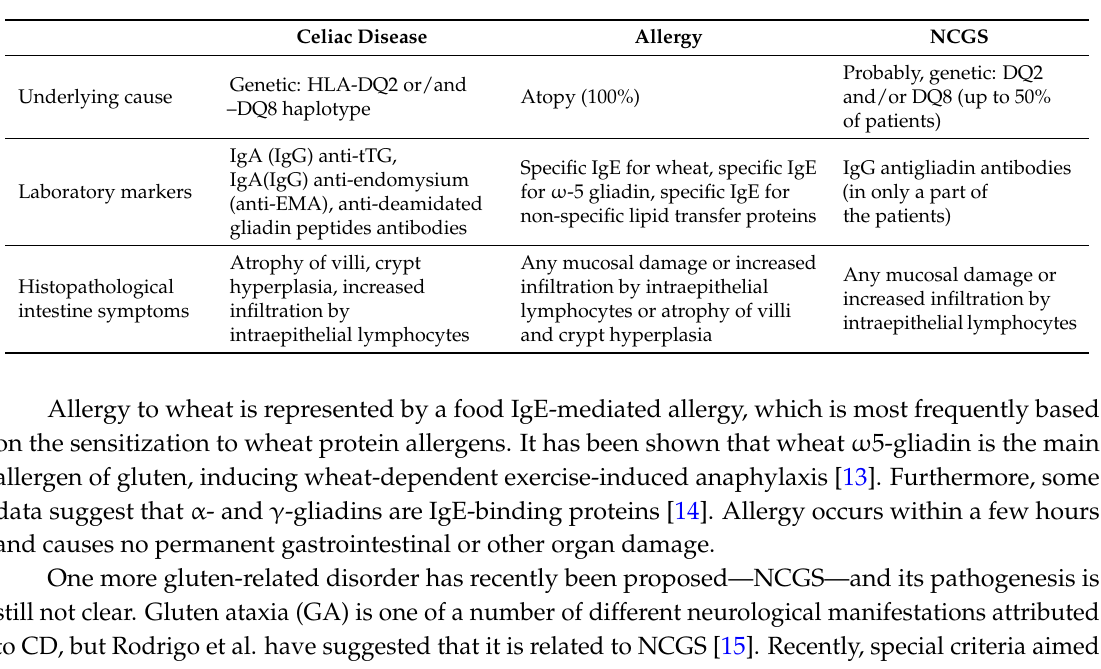
Table 1. Comparative major characteristics of gluten intolerance